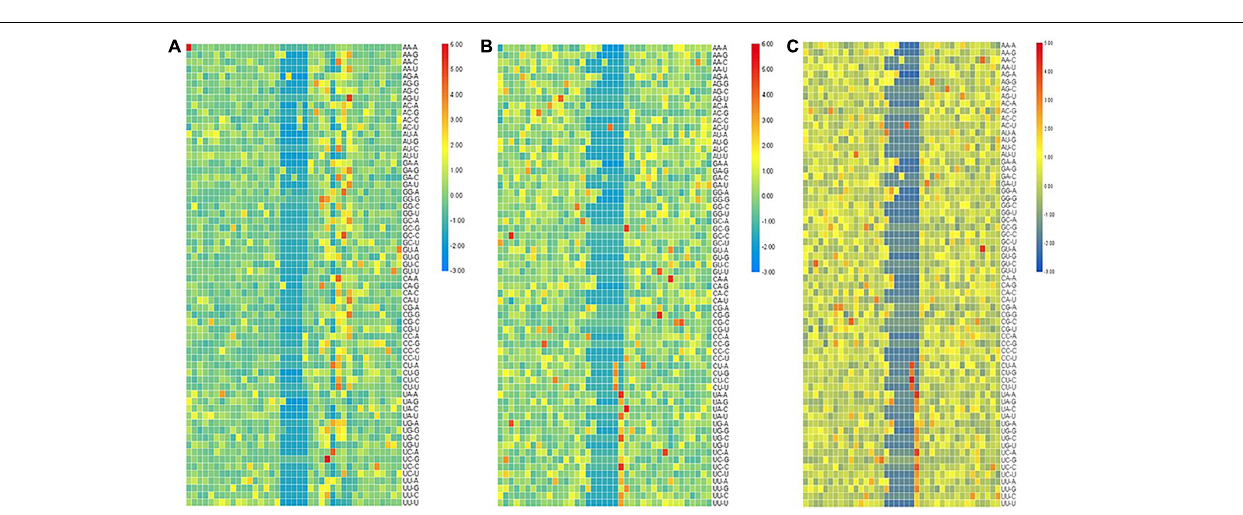
FIGURE 2 | The heat map of standardized quotient of the transfer probabilities of the three types of species. (A) Saccharomyces cerevisiae cells, (B) mouse, and (C) Homo sapiens.